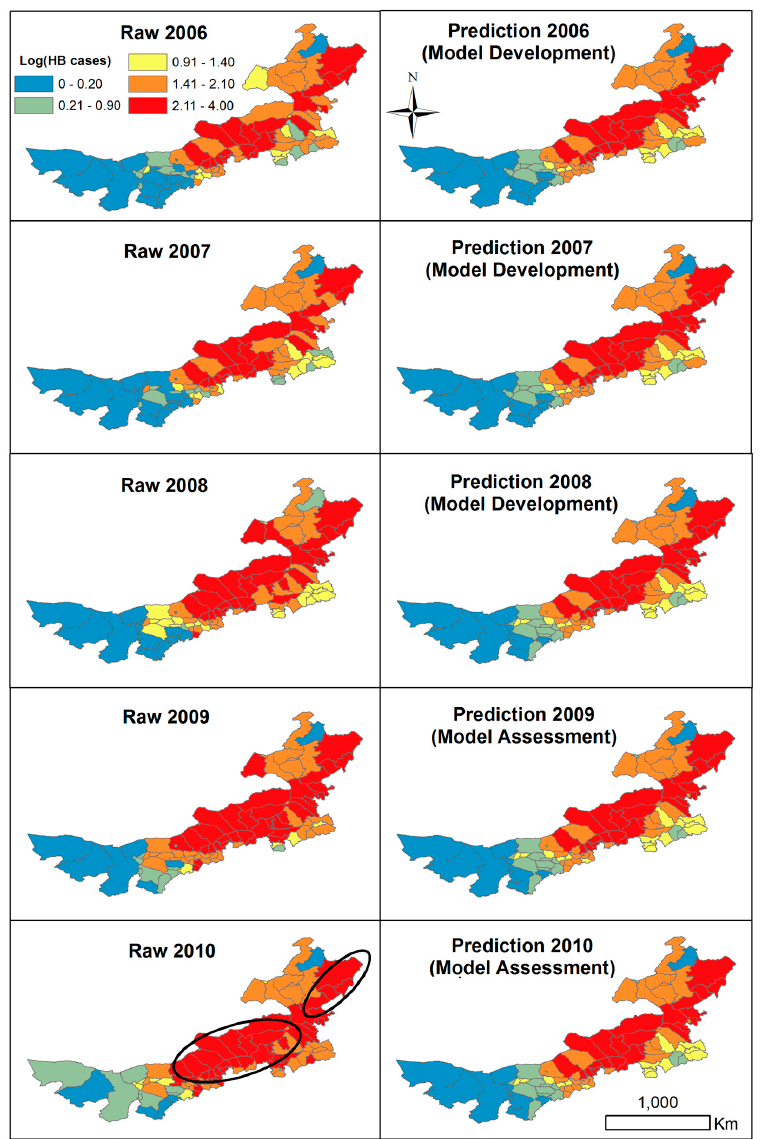
Figure 7. Spatial distribution of predicted and raw yearly log-transformed numbers of human brucellosis (HB) cases during 2006–2010 in Inner Mongolia, China. The location of the major and minor hot spots is marked by the large and small black circles, respectively.